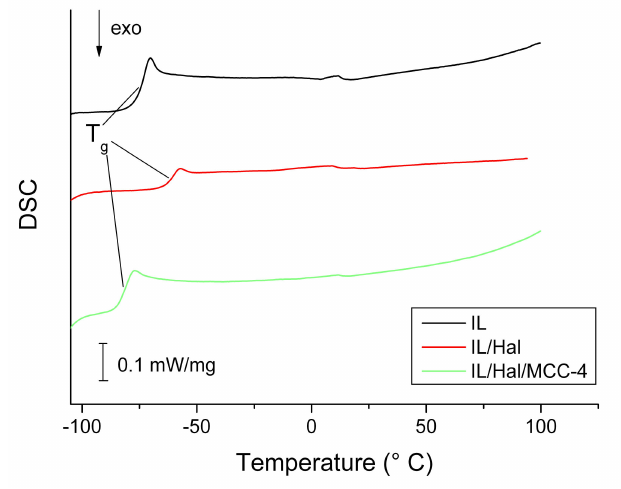
Figure 4. DSC data for BMImAc ionic liquid and BMImAc/Hal/MCC ionogels.